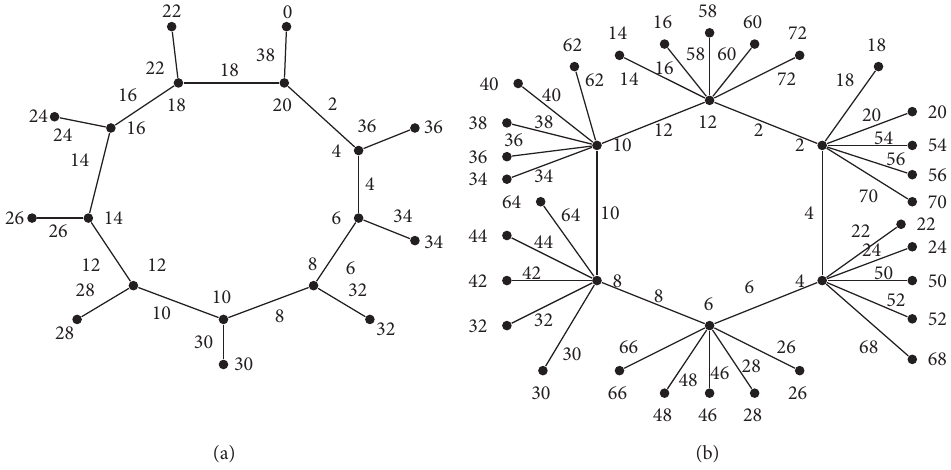
Figure 21: (a) 2-edge even graceful labeling of the crown R